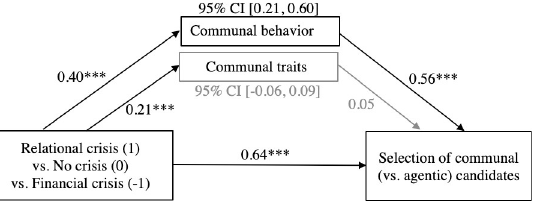
Fig 2. Indirect effect of crisis type (contrast C1), mediated by communal leadership behavior but not communal leadership traits, on the preference for communal (as opposed to agentic) candidates (Study 2, United States of America). Process Model 4 of Hayes (2018, [62]). Numbers indicate unstandardized coefficients. ��� p <